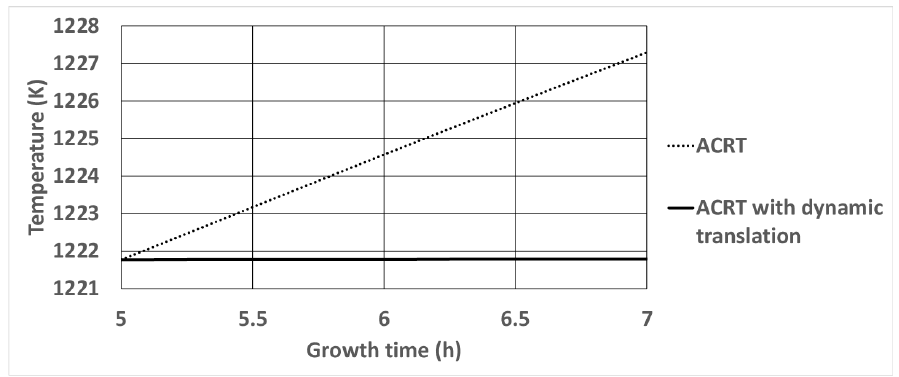
Figure 5. Variation of the interface temperature at the centerline with growth time after the initiation of dynamic translation (t = 5 h).